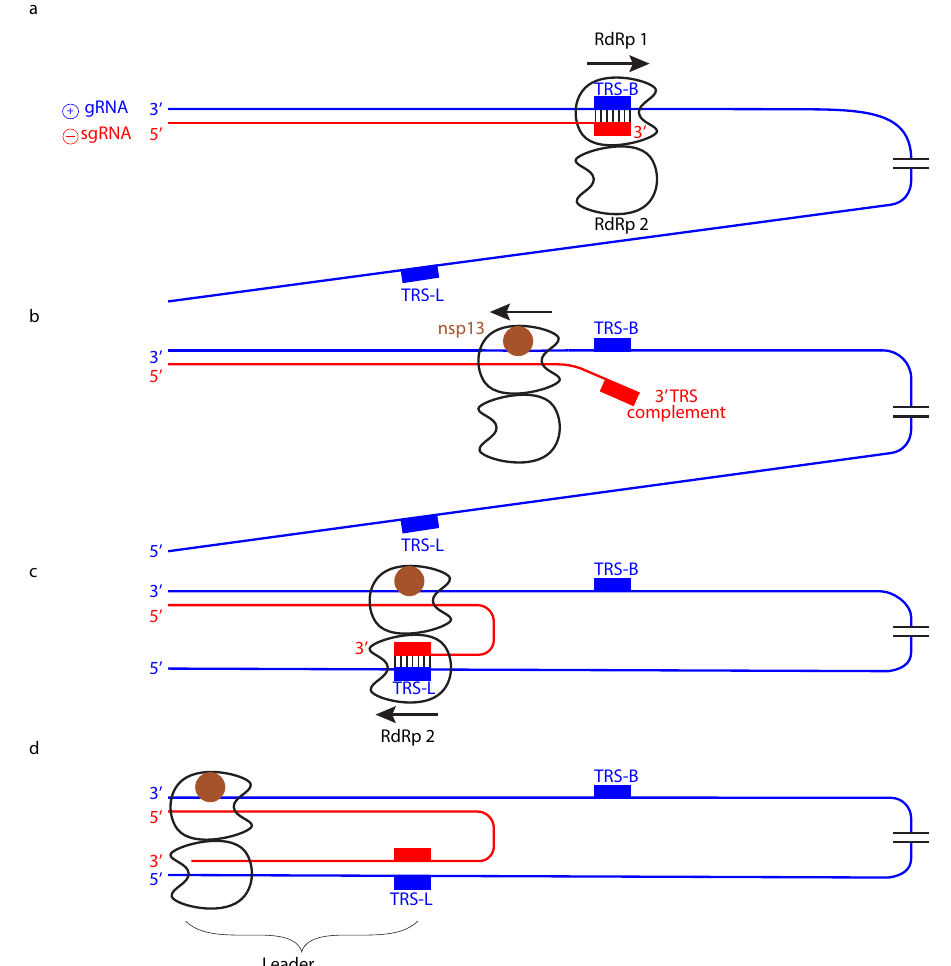
Fig. 2 Hypothetical model of subgenomic RNA production for viral transcription. a Genomic positive-strand ( ⊕ ) RNA (gRNA) is used as a template to produce the 5 ′ region of negative-strand ( ⊖ ) sgRNA until TRS-B is reached by the RdRp monomer 1. b Backtracking is mediated by nsp13 helicase and exposes the newly synthesized, complementary TRS sequence. c The complementary sequence in sgRNA can pair with the downstream TRS-L in gRNA and is then loaded into RdRp monomer 2. d RdRp 2 then completes ⊖ sgRNA synthesis while RdRp 1 backtracks